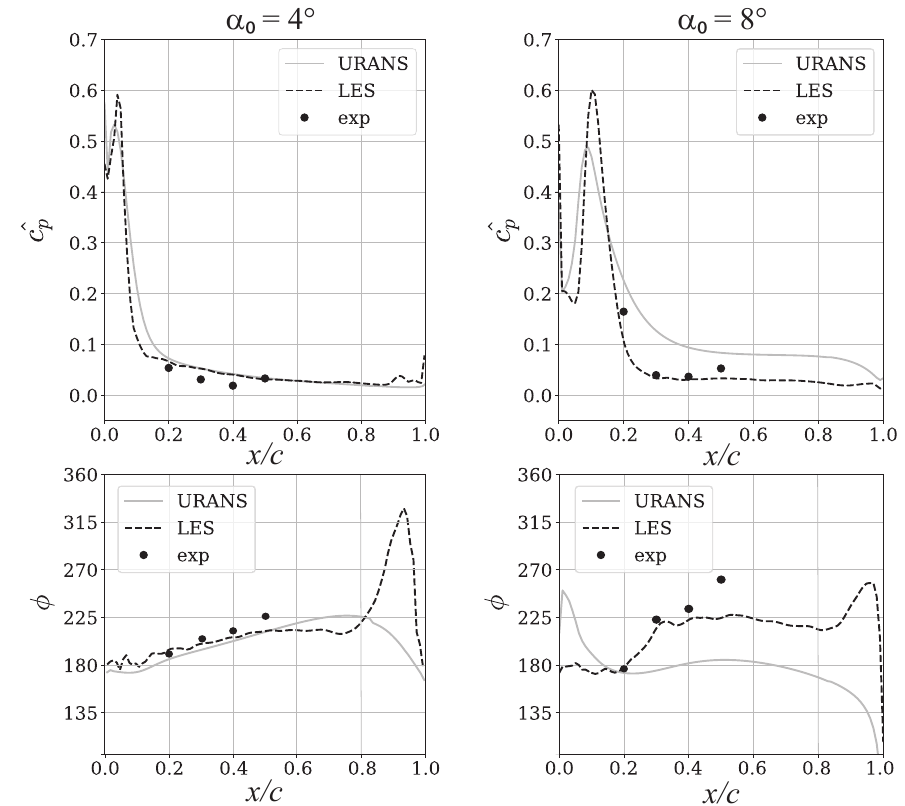
Figure 9. Unsteady surface pressure amplitude and phase as predicted by URANS and LES on the suction side at z ref = 0.24 c . Oscillation frequency: k =